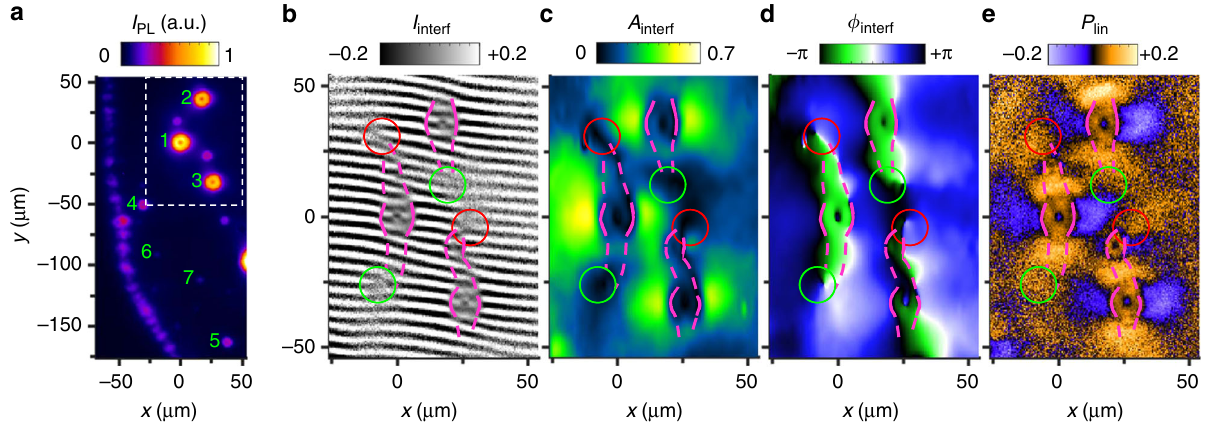
Fig. 1 IX coherence and polarization patterns. a IX emission image showing LBS 1 – 7 numbered according to their emission power. The external ring is seen on the left. b – e Coherence and polarization patterns in the region of LBS 1 – 3 marked by the dashed rectangle in a . b Shift-interference pattern of IX emission, I interf ( x , y ). The shift δ x = 2 μ m. c , d Amplitude ( c ) and phase ( d ) of interference fringes in b , A interf ( x , y ) and ϕ interf ( x , y ). e The linear polarization of IX emission, P linear ( x , y ). In b , the positions of phase shifts of interference fringes are marked by magenta lines and the positions of left (right) forks of interference fringes are marked by green (red) circles. The lines are solid in the circular region around each LBS where the phase shifts are sharp and dashed outside these regions where the phase shifts are smoother. These lines and circles are copied to c – e to show spatial correlations in A interf ( x , y ), ϕ x , y ), and P x , y ). Excitation power P = 1.2 mW. T = 0.1 interf ( linear ( bath